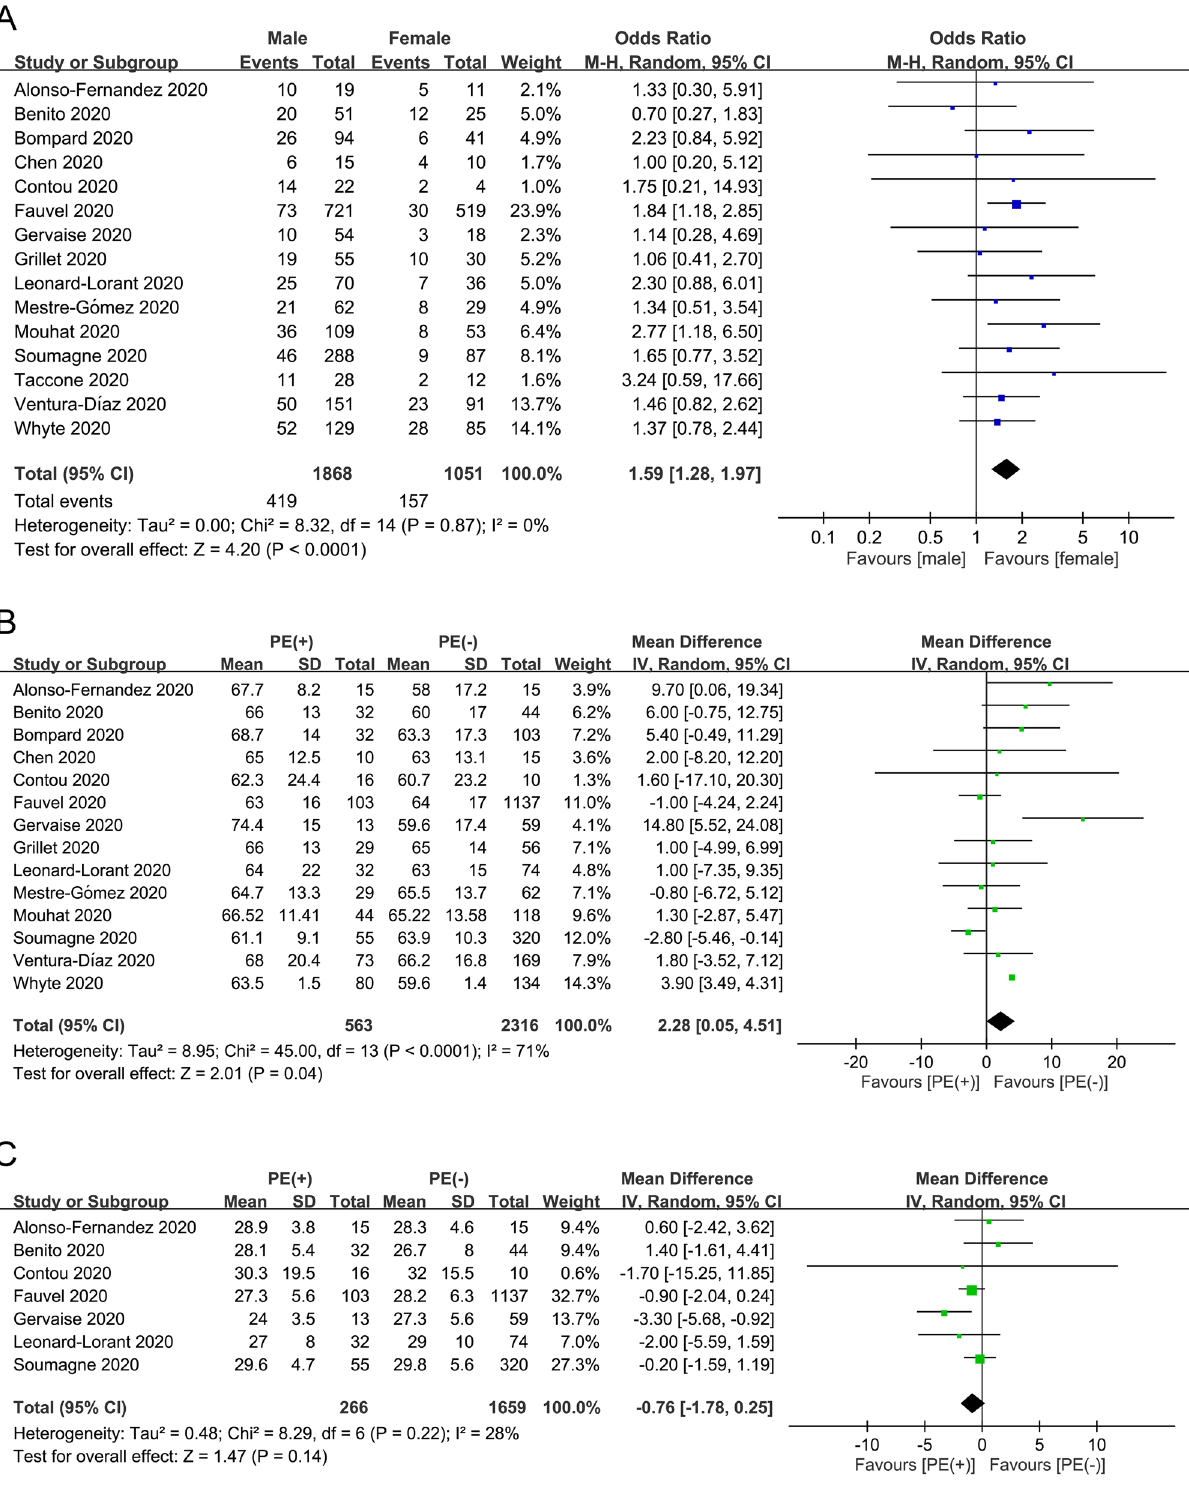
Figure 5. Forest plots for assessing the difference in ( A ) Gender; ( B ) Age; and ( C ) Body mass index between pulmonary embolism (PE) and non-PE groups. CI = confidence interval, M-H = Mantel–Haenszel, IV = inverse